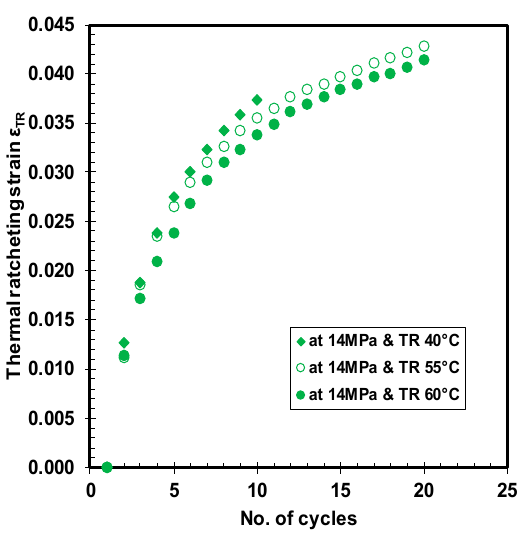
Figure 12. Thermal ratcheting strain under different ratcheting temperature ranges.